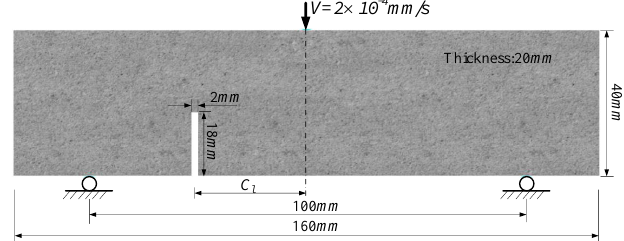
Figure 1. Geometry of the notched beam specimen and the loading conditions of the